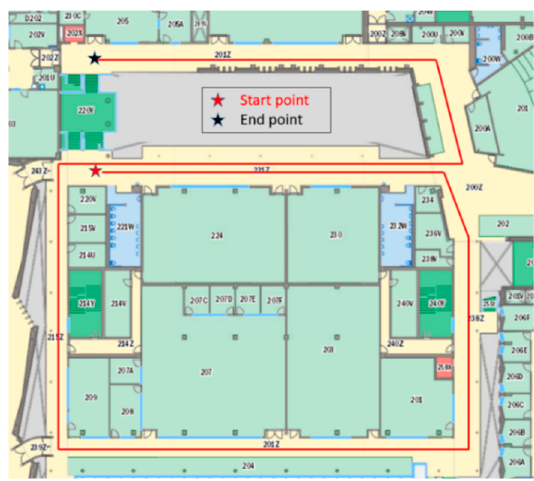
Figure 19. Engineering G (ENG) building trajectory.